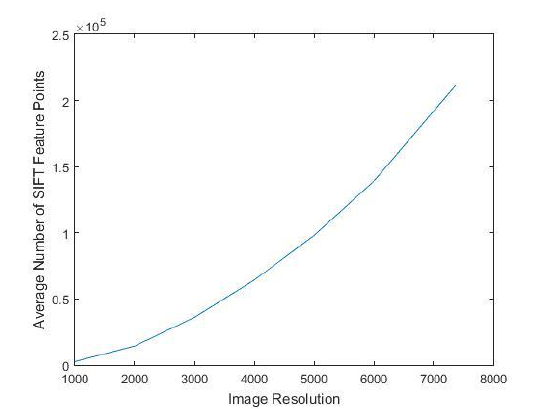
Figure 8. Average number of SIFT feature points extracted from different resolution image sets